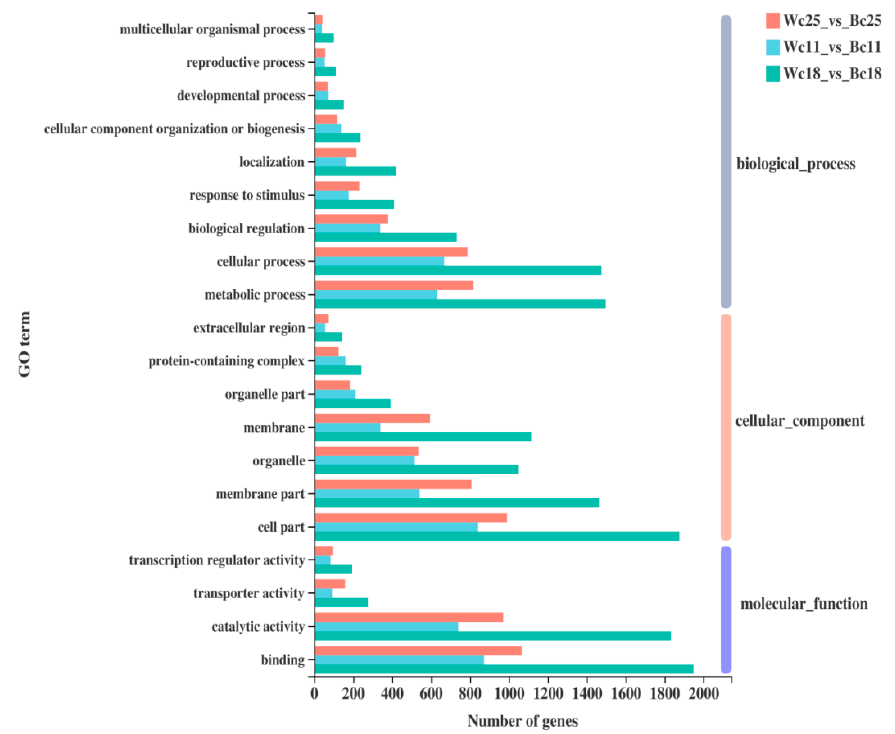
Figure 6. Gene ontology analysis of DEGs; results are shown in three categories: Biological Process (gray), Cellular Component (orange), and Molecular Function (violet); the left axis represents the num- ber of genes of each term, while the Y -axis represents the GO term; different colored bars represent different comparisons.